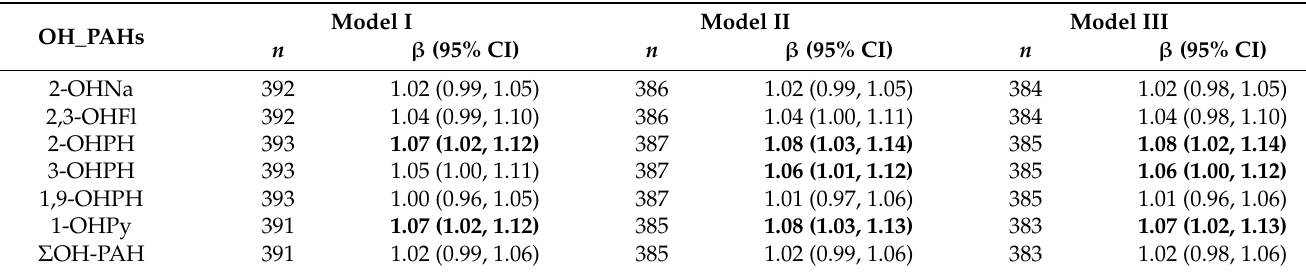
Table 5. Linear regression analyses of urinary OH-PAHs concentrations with urinary 8-oxodG.